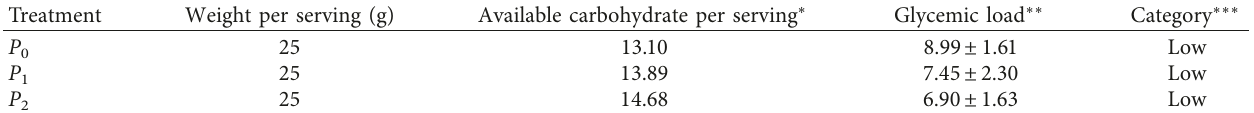
Table 5: Cookies with tempeh gembus flour substitution’s glycemic load. Treatment